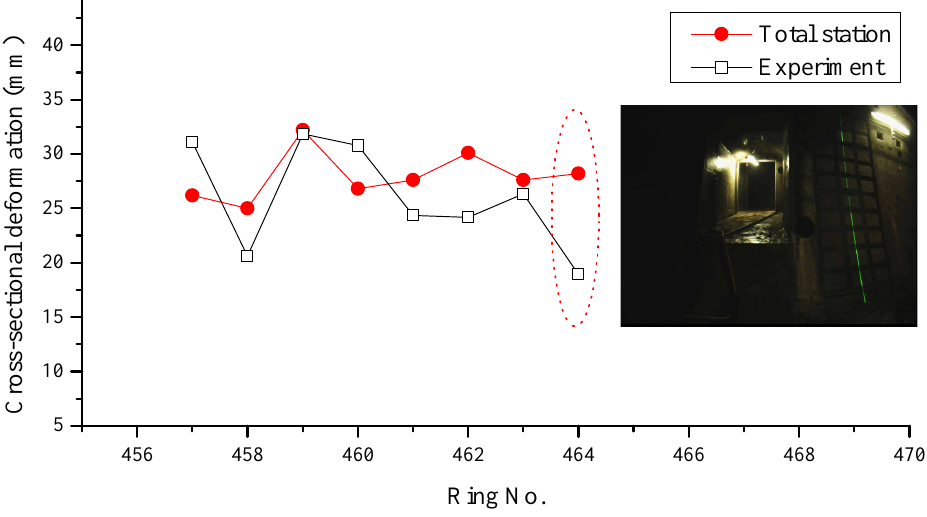
Figure 17. Discrepancy of cross-sectional deformation close to a cross-passage of the metro